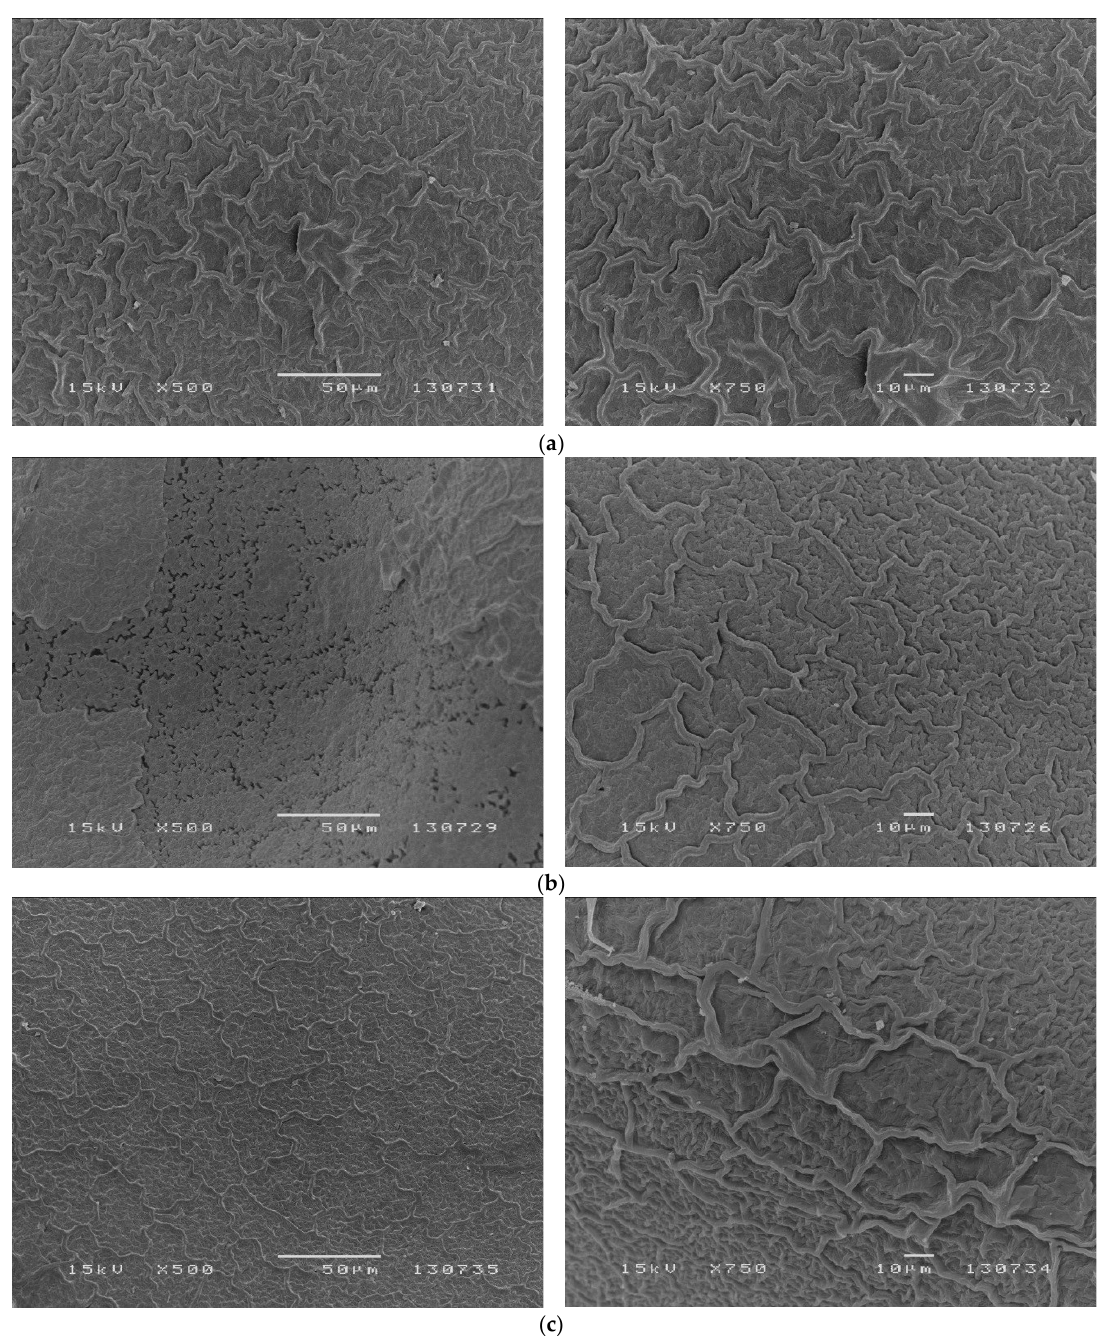
Figure 3. Seed coat morphology of Cistus ladanifer . Scanning electron photomicrographs at two magnifications of ( a ) untreated seeds; ( b ) seeds with epicuticular waxes removed with hexane; ( c ) seeds treated with 90 °C.